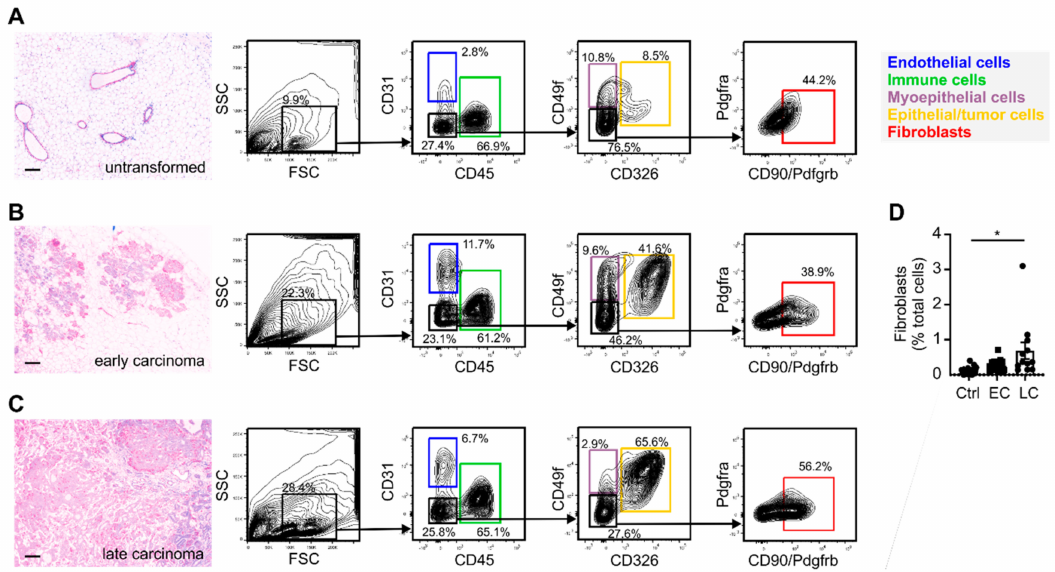
Figure 3. FACS of fibroblasts from untransformed mammary gland, early and late PyMT tumors. Untransformed mammary glands (Ctrl) as well as early (EC; 8–12 weeks) and late stage (LC; 18–20 weeks) PyMT tumors were harvested. Single cell suspensions were stained for the markers indicated and subjected to flow cytometric analysis and FACS-Sorting. Fibroblasts were identified as CD31 − CD45 − CD49f − CD326 − Pdgfrb + cells. Mock H&E images (scale bars: 100 µ m) indicating tissue architecture and the sorting strategies for untransformed mammary glands ( A ), early- ( B ) and late-stage ( C ) PyMT tumors and the quantification of fibroblast abundance ( D ) are displayed. ( D ) Individual data points, means + SEM are shown. p -values were calculated using one-way ANOVA with Bonferroni’s correction, * p <